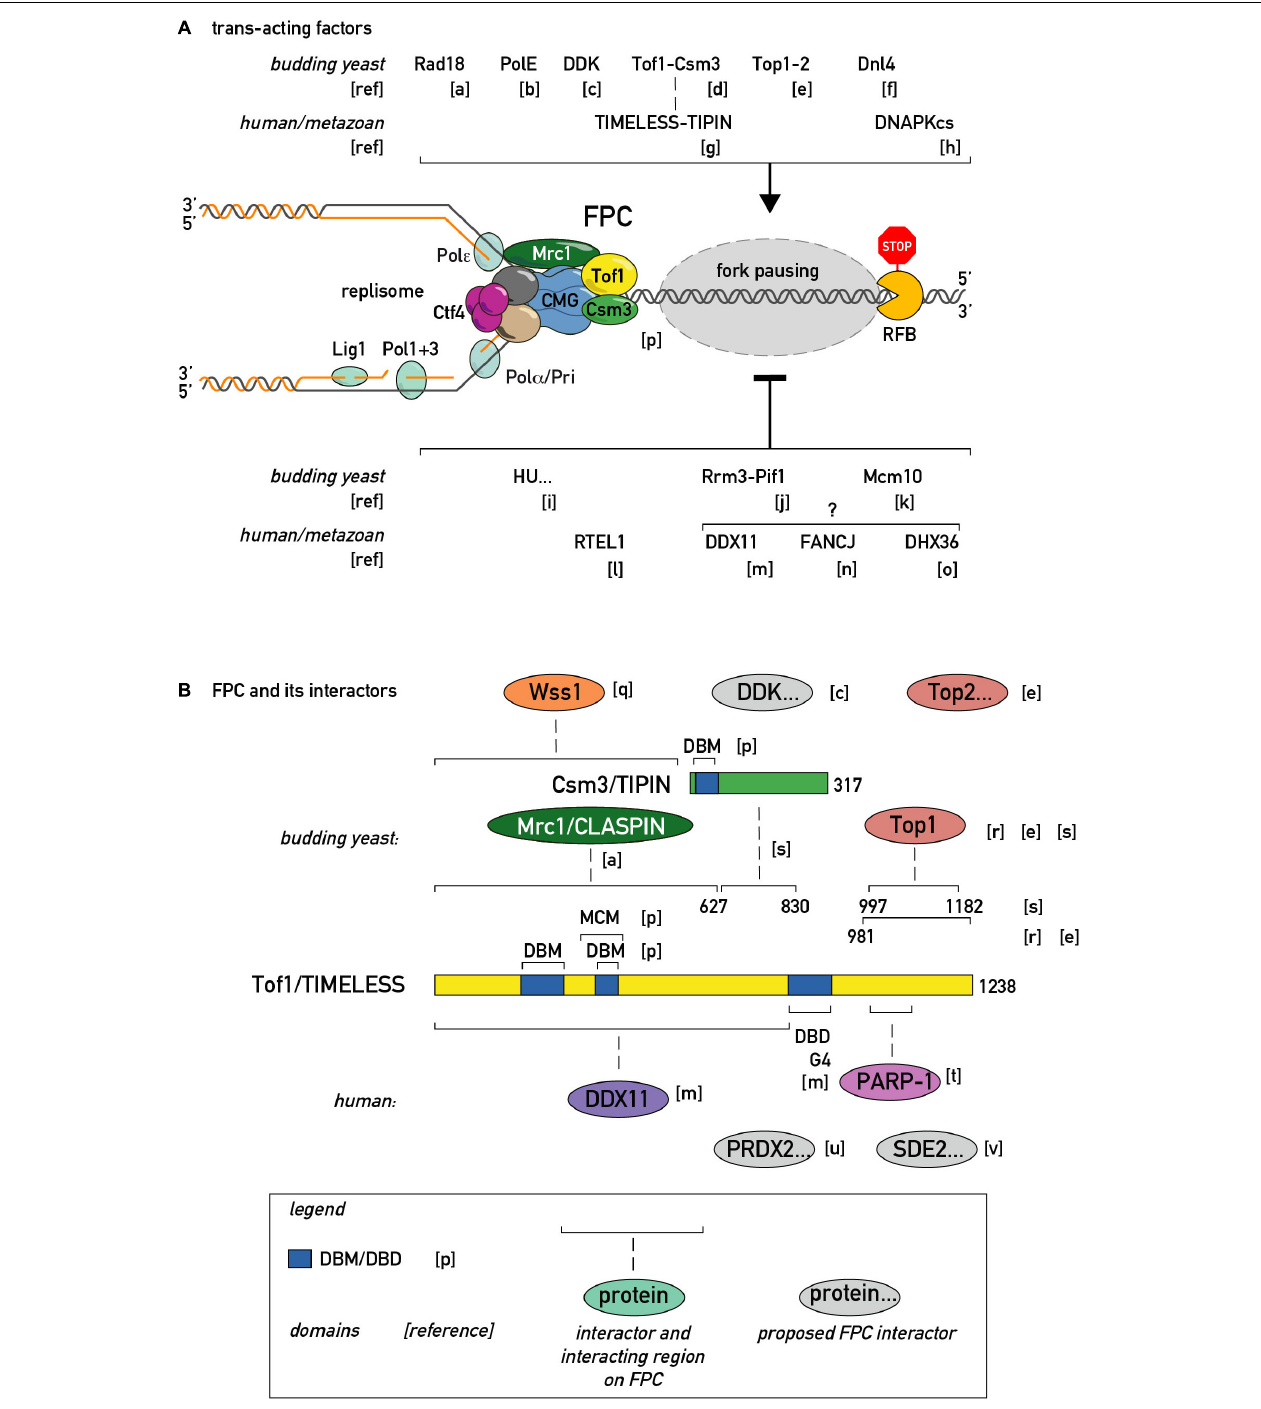
FIGURE 3 | Regulators of fork pausing. (A) Trans -acting proteins and a chemical proposed to modulate replication fork progression through a barrier promoting pausing (top of the schematic with activatory arrow sign) or alleviating it (bottom of the schematic with inhibitory bar sign). (B) MTC (Mrc1-Tof1-Csm3) protein domain structure, proposed protein-protein interactions, and interacting regions in budding yeast and human cells. DBD/M—DNA binding domain/motif. MCM—MCM2-7 binding motif. G4—G-quadruplex binding region. [a]–(Yeung and Smith, 2020), [b]–(Hizume et al., 2018), [c]–(Bastia et al., 2016),